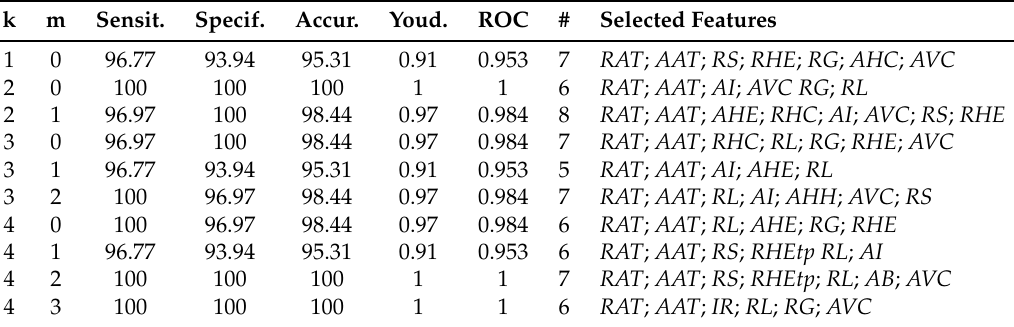
Table 5. Result of the classification with Nu-SVC for each series after the feature selection. k m